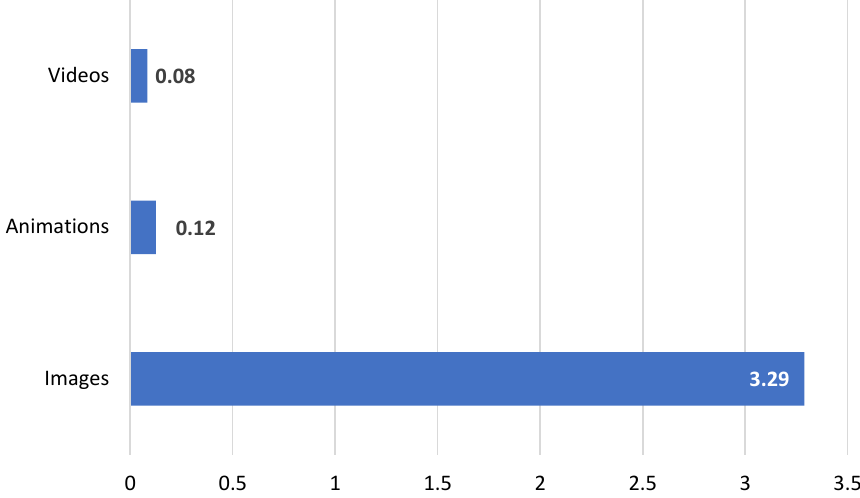
Figure 2. Graph of the average of type of posts generated by the students.